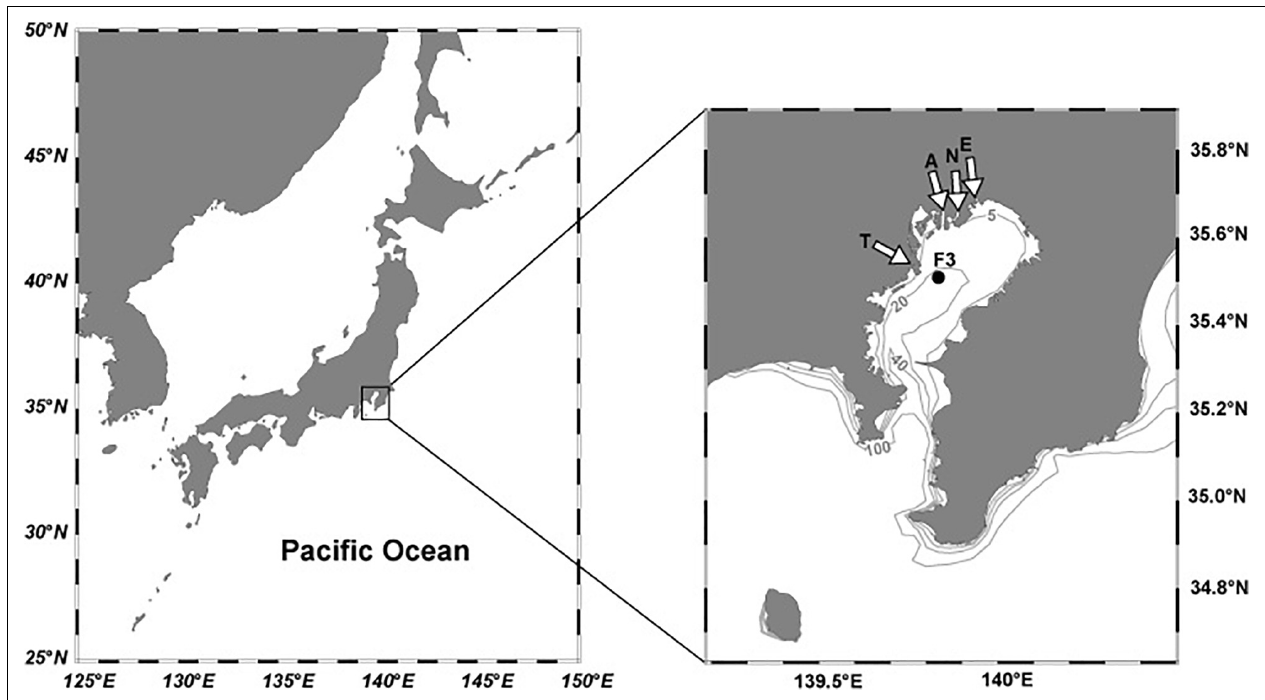
FIGURE 1 | Map of Tokyo Bay and the sampling location. White arrows indicate the major rivers (E, Edogawa; N, Nakagawa; A, Arakawa; T, Tamagawa rivers). Gray lines with numbers indicate the bathymetry in